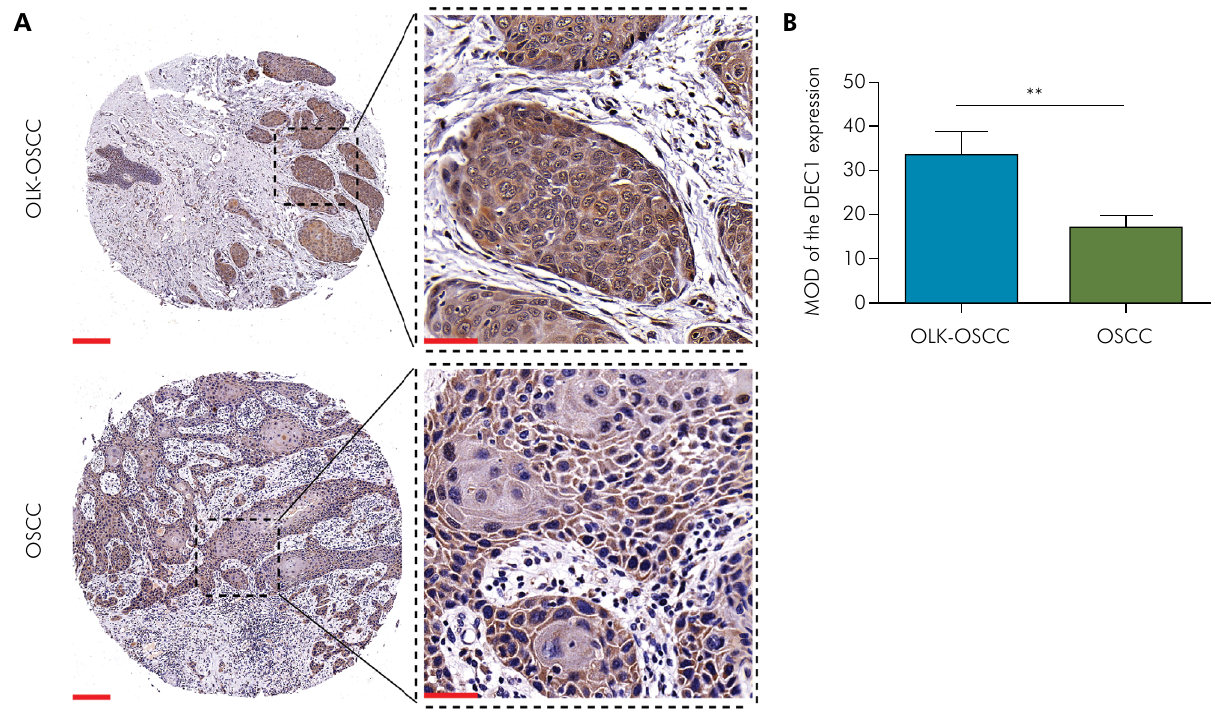
Figure 3. Differential expression of DEC1 between oral squamous cell carcinoma (OSCC) that originated from oral leukoplakia (OLK) and other OSCC: (A) Immunohistochemical staining for DEC1 in OSCC and OLK-OSCC. Scale bar (left side) = 200 μm, scale bar (right side) = 50 μm. (B) The expression of DEC1 in the OSCC group in OSCC that originated from OLK was higher than that in OSCC that did not, and the difference was statistically significant. **indicates p < 0.01, the bar on the column refers to SEM: Structural Equation